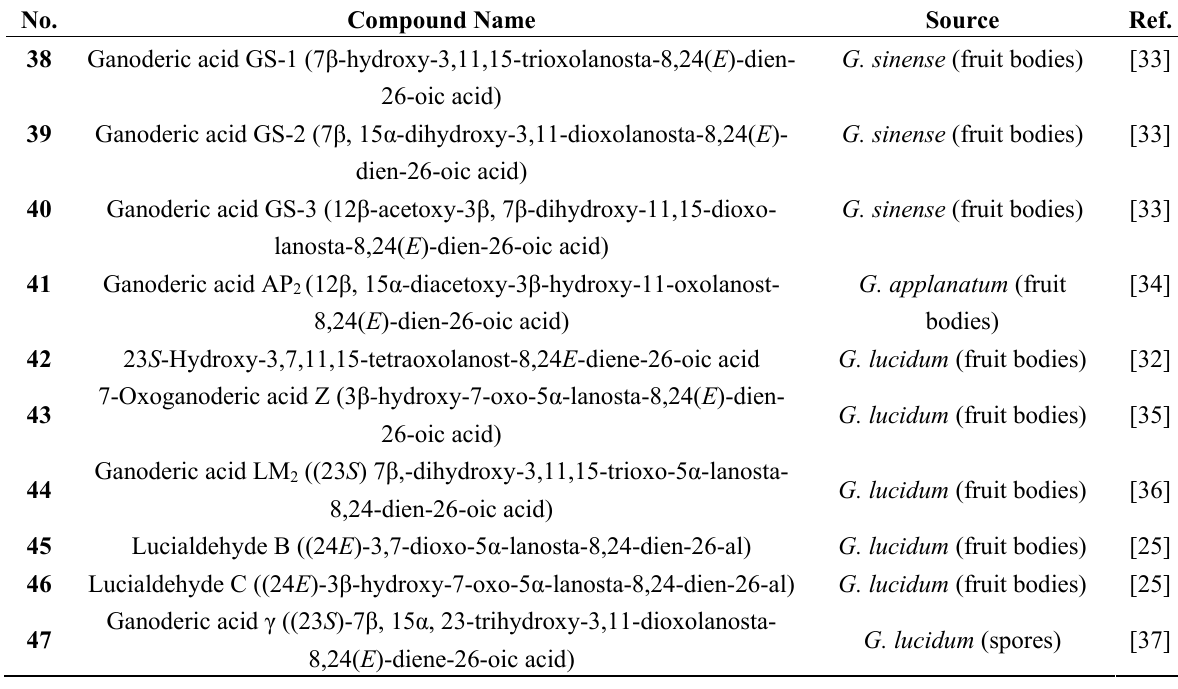
Table 2. Ganoderma triterpenes ( 38 – 70 ) in Figure